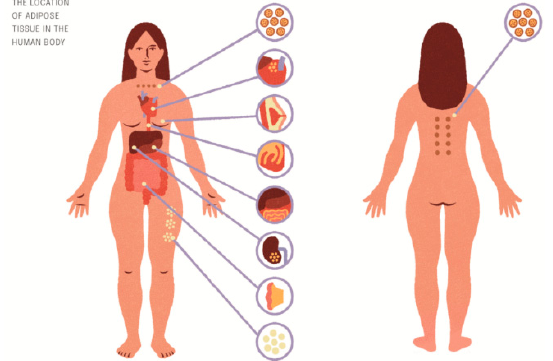
Figure 1. The location of adipose tissue in the human body. In the human body there are three major types of adipose tissue: nonthermogenic white adipose tissue and two types of thermogenic adipose tissue: constitutively brown and inducible beige adipocytes. In the figure we have also presented another types of adiose tissue: epicardial WAT and pink adipose tissue (PINK).